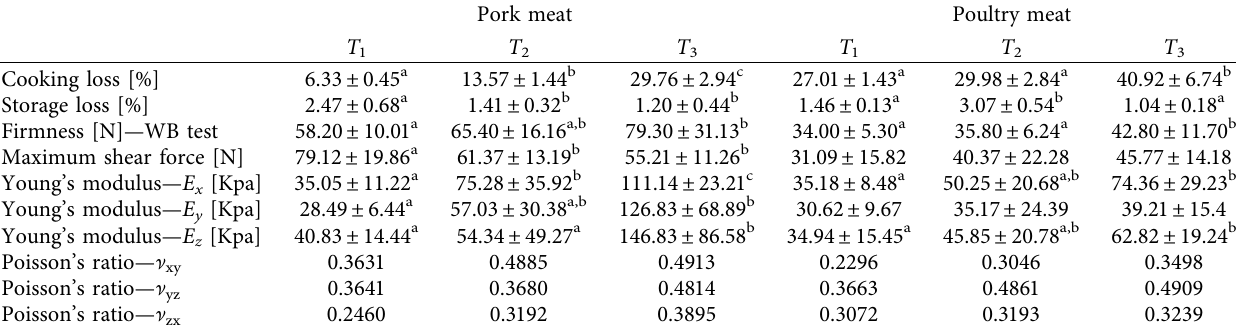
Table 4: Summary of mechanical properties for samples prepared using three grilling